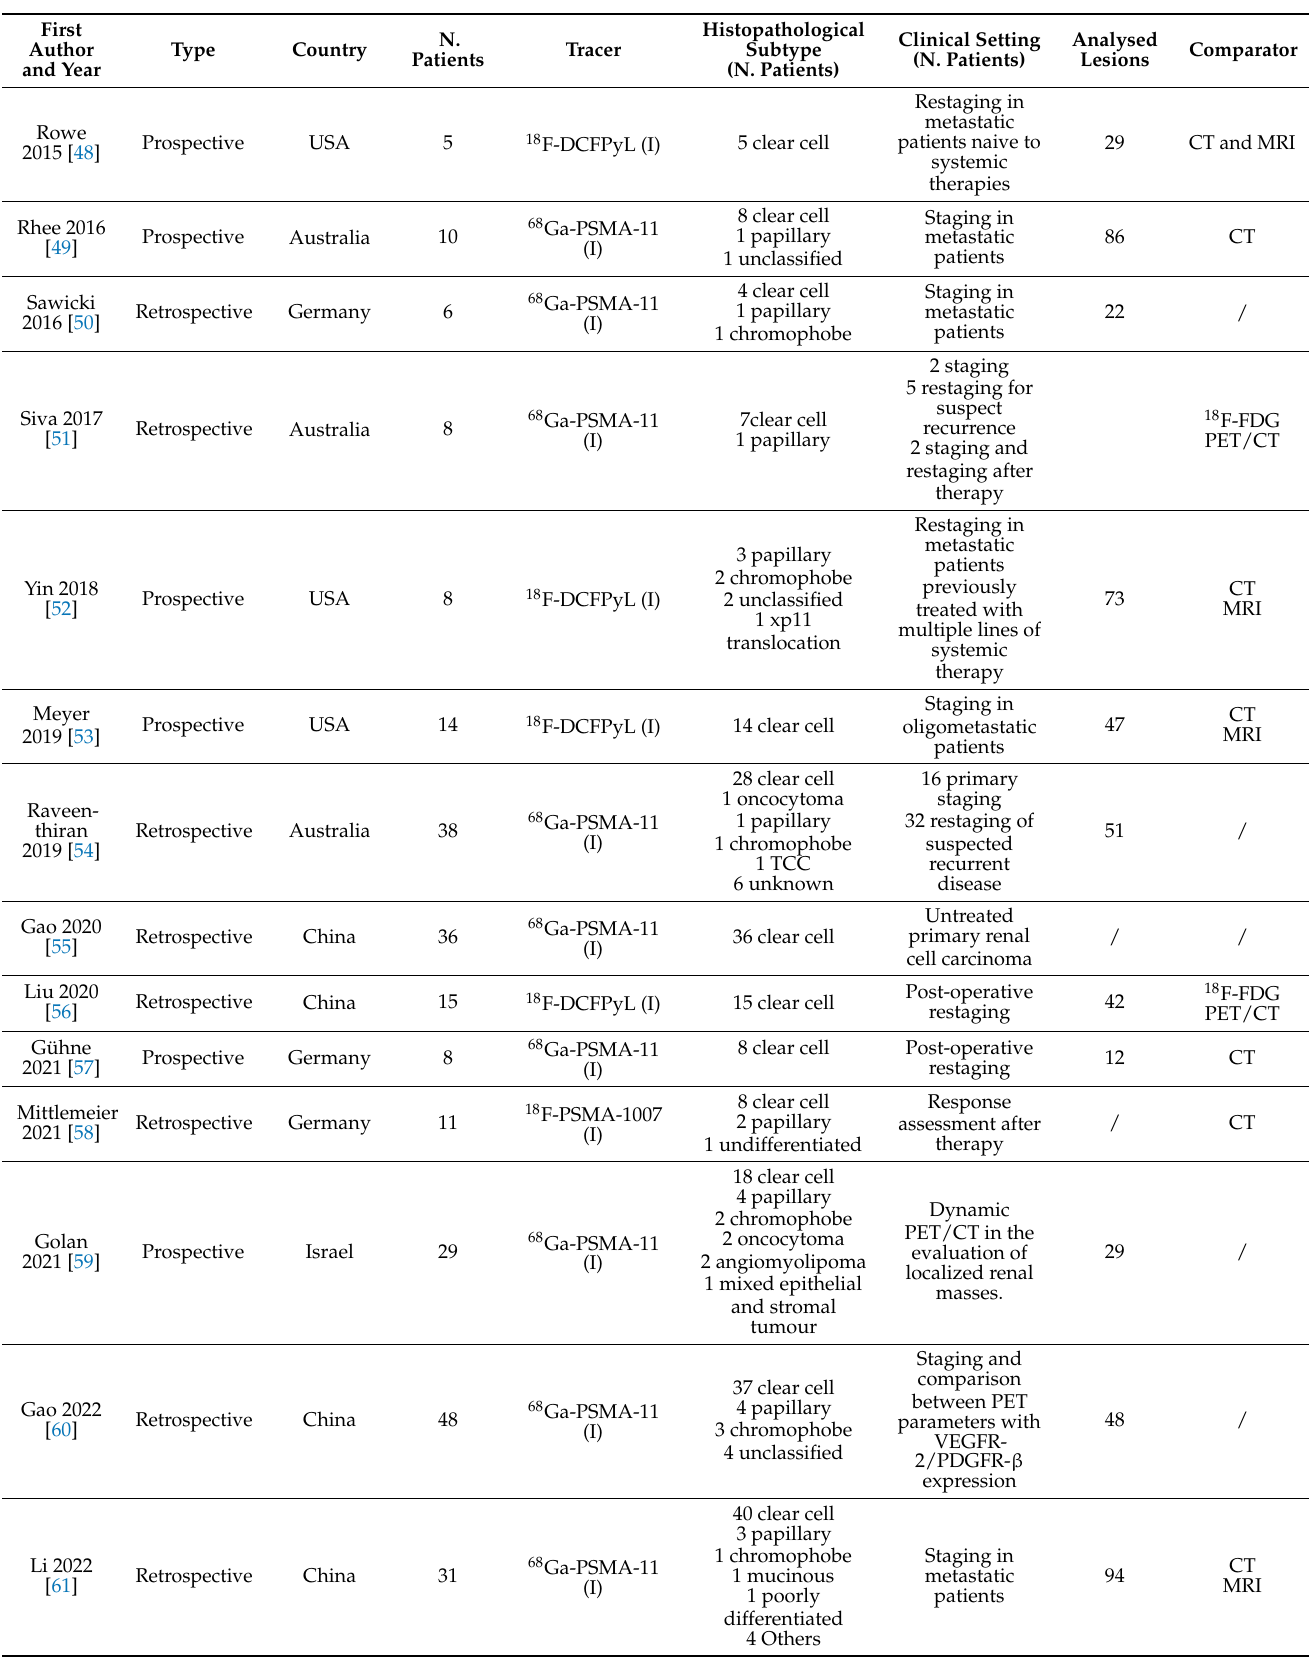
Table 5. Characteristics of the included studies which employed PSMA radioligands in renal cell